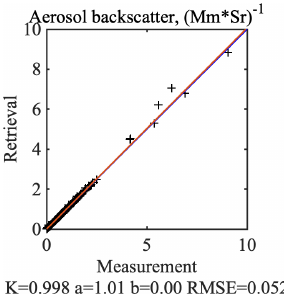
Figure 11. Achieved backscatter fits for the multi-temporal re- trievals performed on 5, 11 August 2015 and 12 August